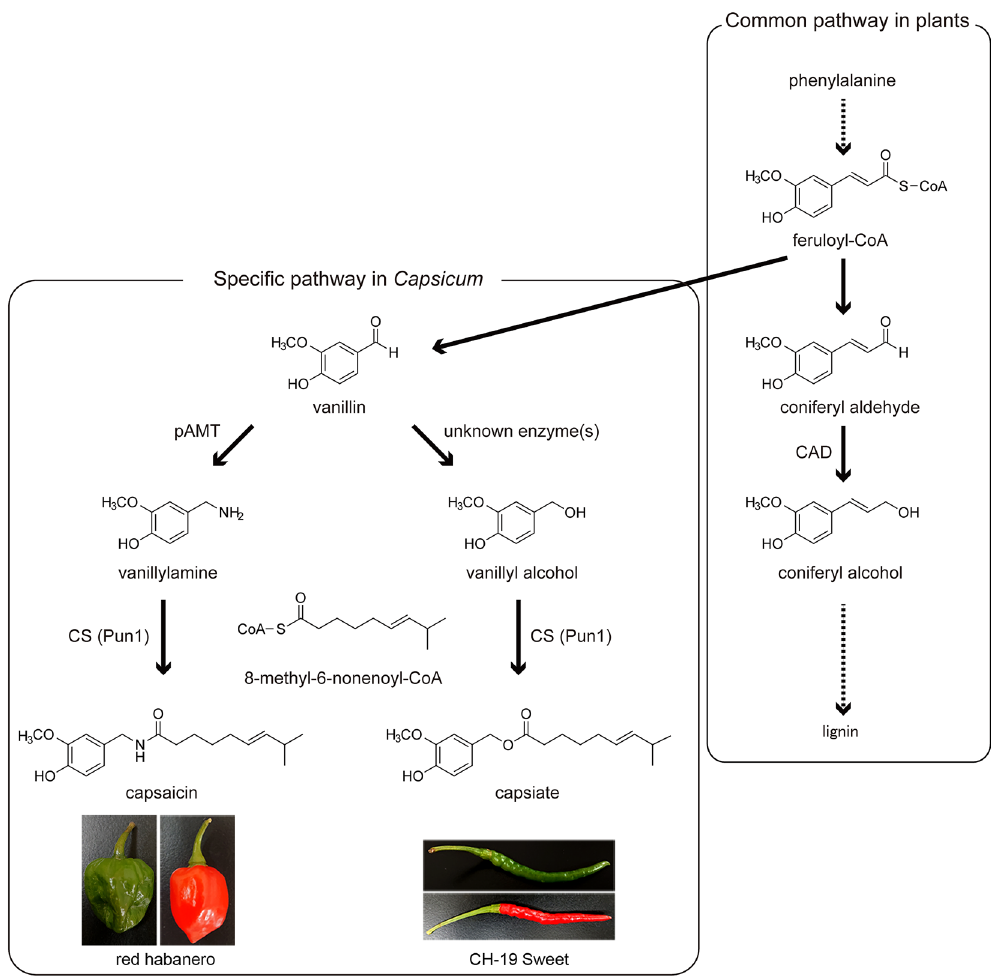
Figure 1. Partial capsaicin, capsiate, and lignin biosynthetic pathways. Capsicum -specific capsaicin and capsiate biosynthetic pathways are branched from the lignin biosynthetic pathway in plants. The intermediate products and the main enzymes catalyzing each reaction are shown. Examples of varieties producing capsaicin and capsiate are provided at the